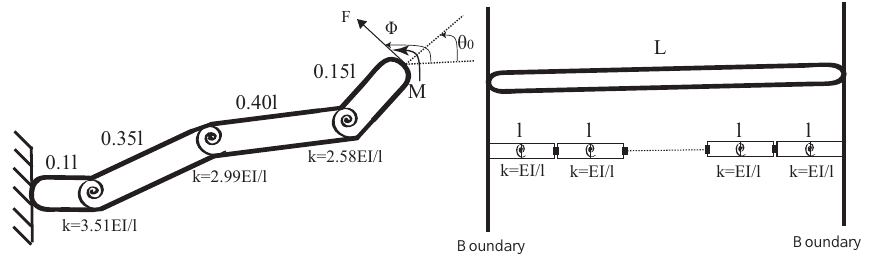
Figure 2. The PRB-3R model (left) and the finite segment model (right) for compliant beams.